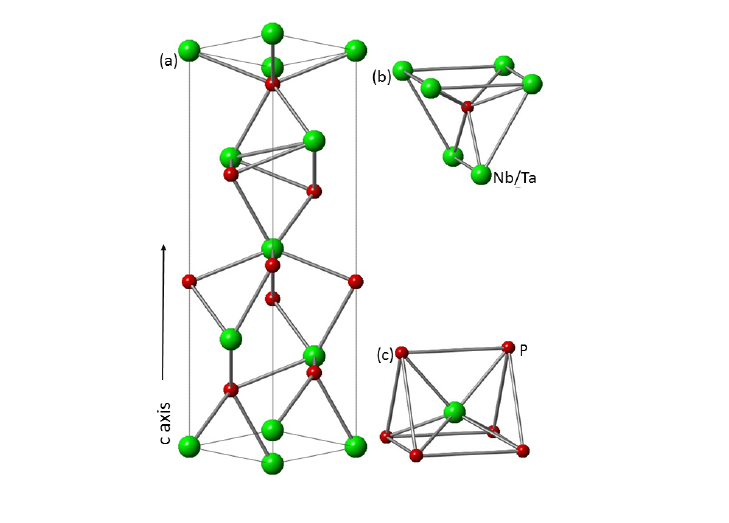
Figure 1. Conventional unit cell of NbP or TaP ( a ); Trigonal prismatic environment of P ( b ) and Nb/Ta ( c ).